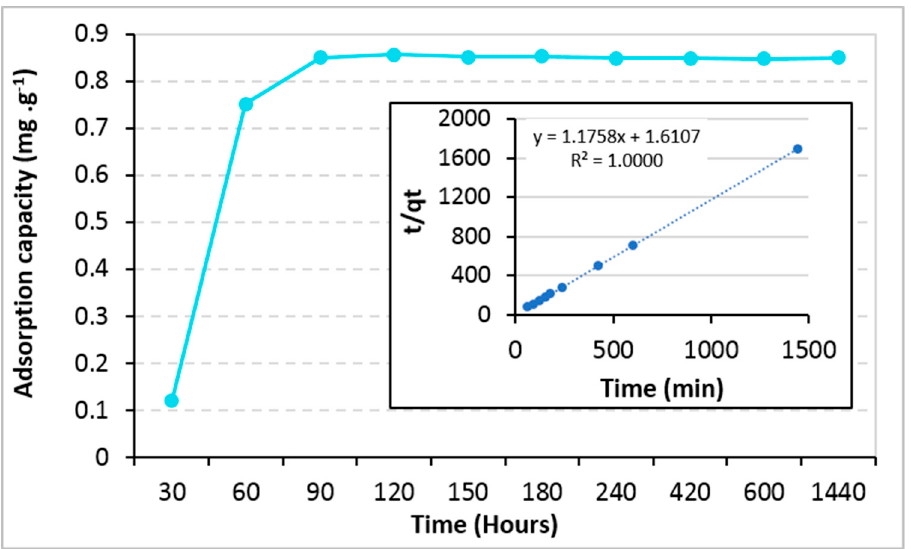
Figure 7. Adsorption capacity of (TiO 2 ) 100 (VPA) toward benzo(a)pyrene as a function of time. Insert: Pseudo-second model for benzo(a)pyrene adsorption kinetics.